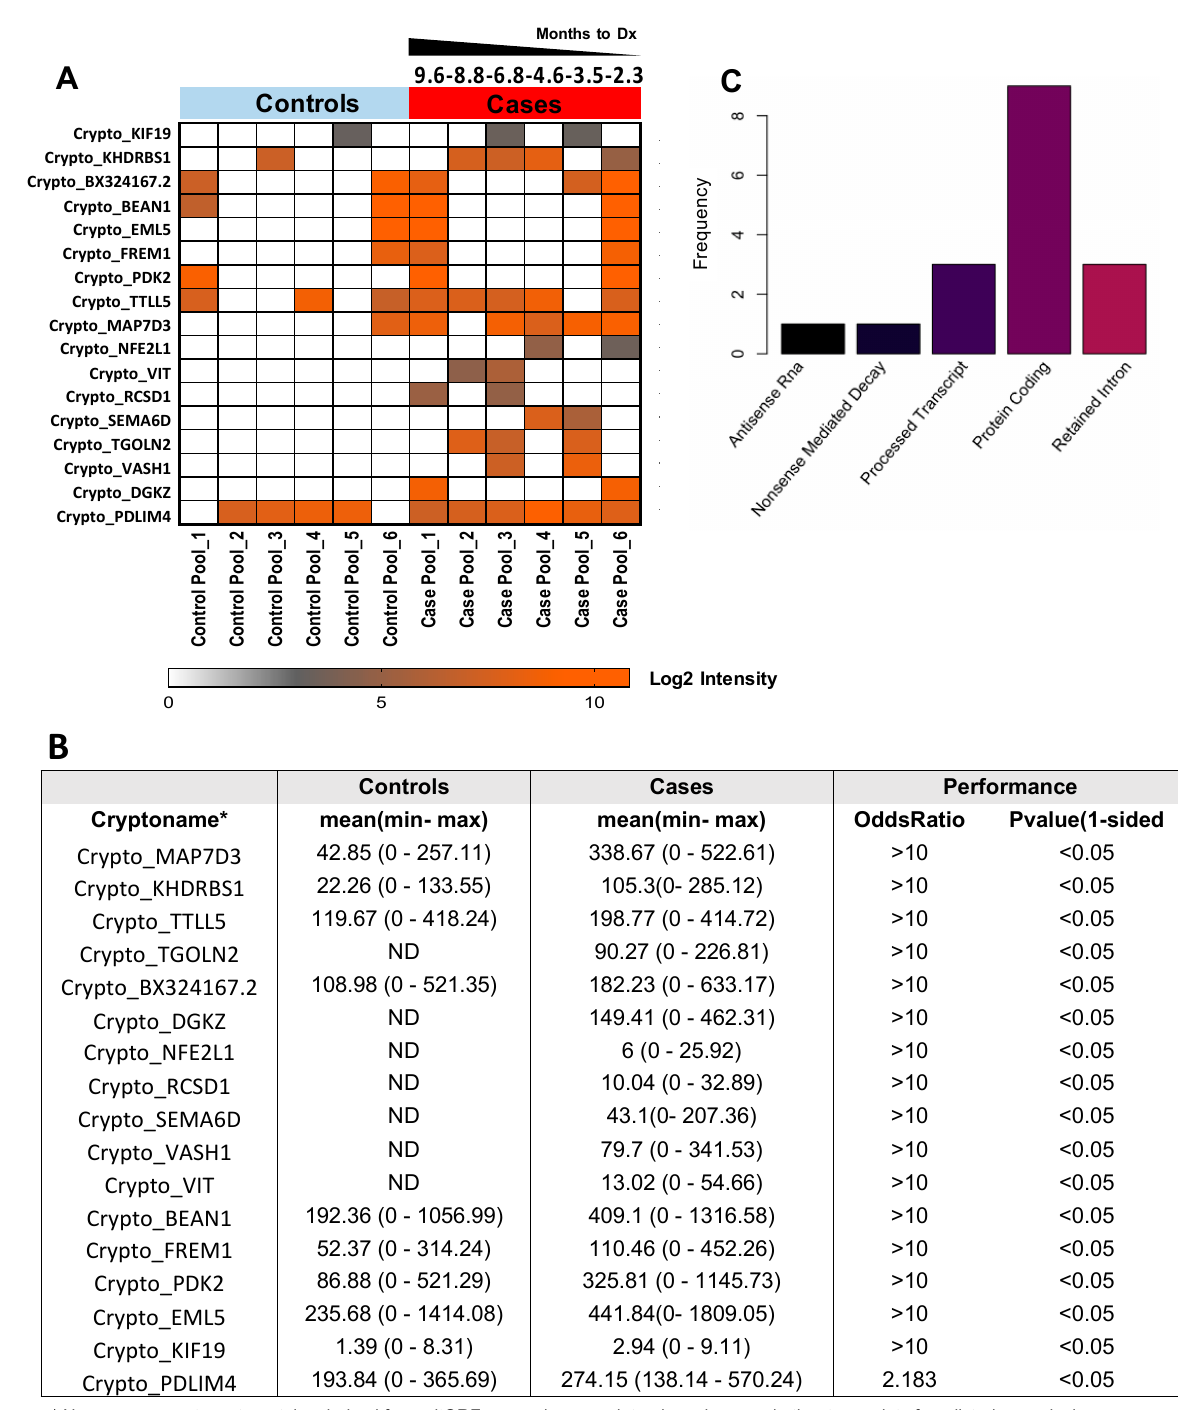
Figure 3. Ig-bound cryptoproteins are detectable in NSCLC pre-diagnostic plasma: ( A ) Heatmap showing 17 Ig-bound cryptoproteins that were elevated (OR > 2; 1-sided p value < 0.05) in plasmas collected within 1 year of a lung cancer diagnosis compared to controls. Abbreviations: Sq, Squamous Cell Carcinoma; Adc, Adenocarcinoma. ( B ) Tabular representation of the 17 Ig-bound cryptoproteins. ND = Not Detected. ( C ) Histogram detailing the cryptoprotein type for the 17 Ig-bound cryptoproteins that were elevated in cases diagnosed within 1 year of blood draw compared to